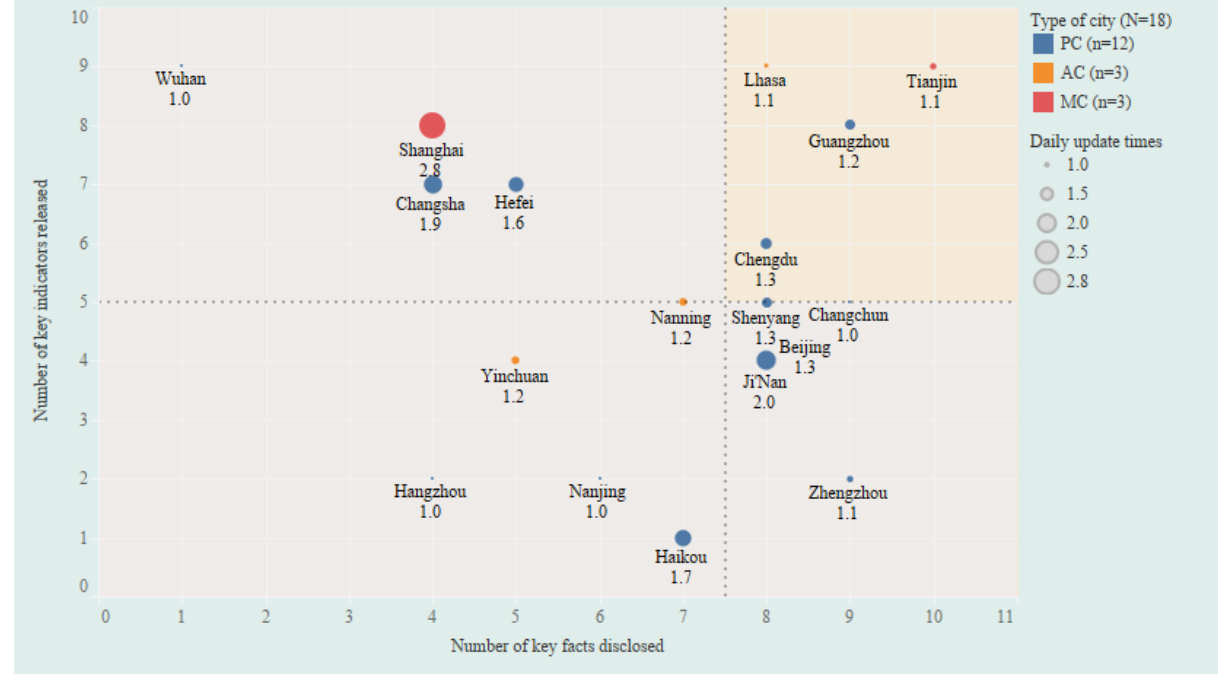
Figure 5. Scatterplots of the key facts disclosed in the case reports versus key indicators released in the epidemic surveillance summaries of 18 cities. The grey-shaded areas indicate cut-offs between the low number of key facts disclosed (lower than the median of 7.5) and the low number of key indicators released (lower than the median of 5.0). The dots representing Beijing and Ji’Nan coincide on the scatterplots. The name of the city and daily update frequencies for epidemic surveillance are displayed in black